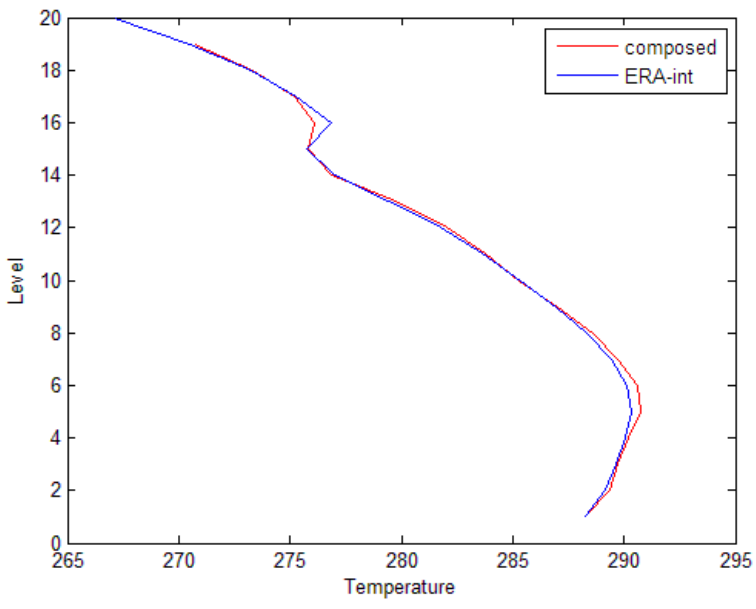
Figure 5. Vertical temperature profile from ERA-Interim ( blue ), together with the reconstructed (interpolated) profile ( red